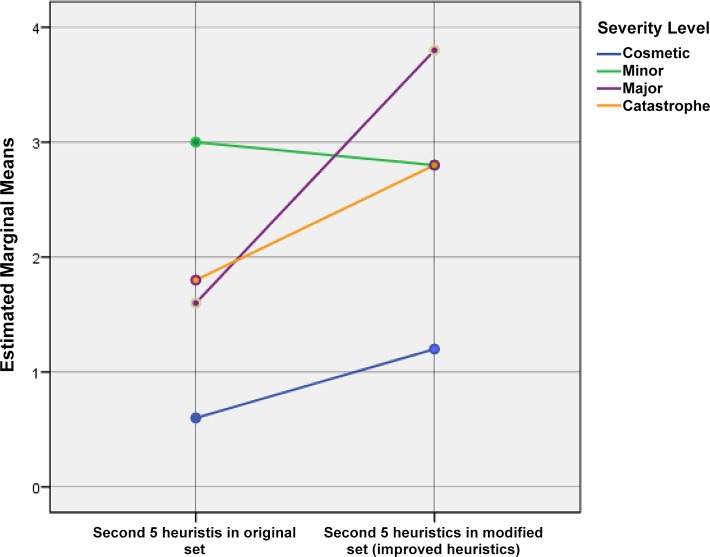
Estimated marginal means of problem identification by groups 2 and 4 at different severity levels.